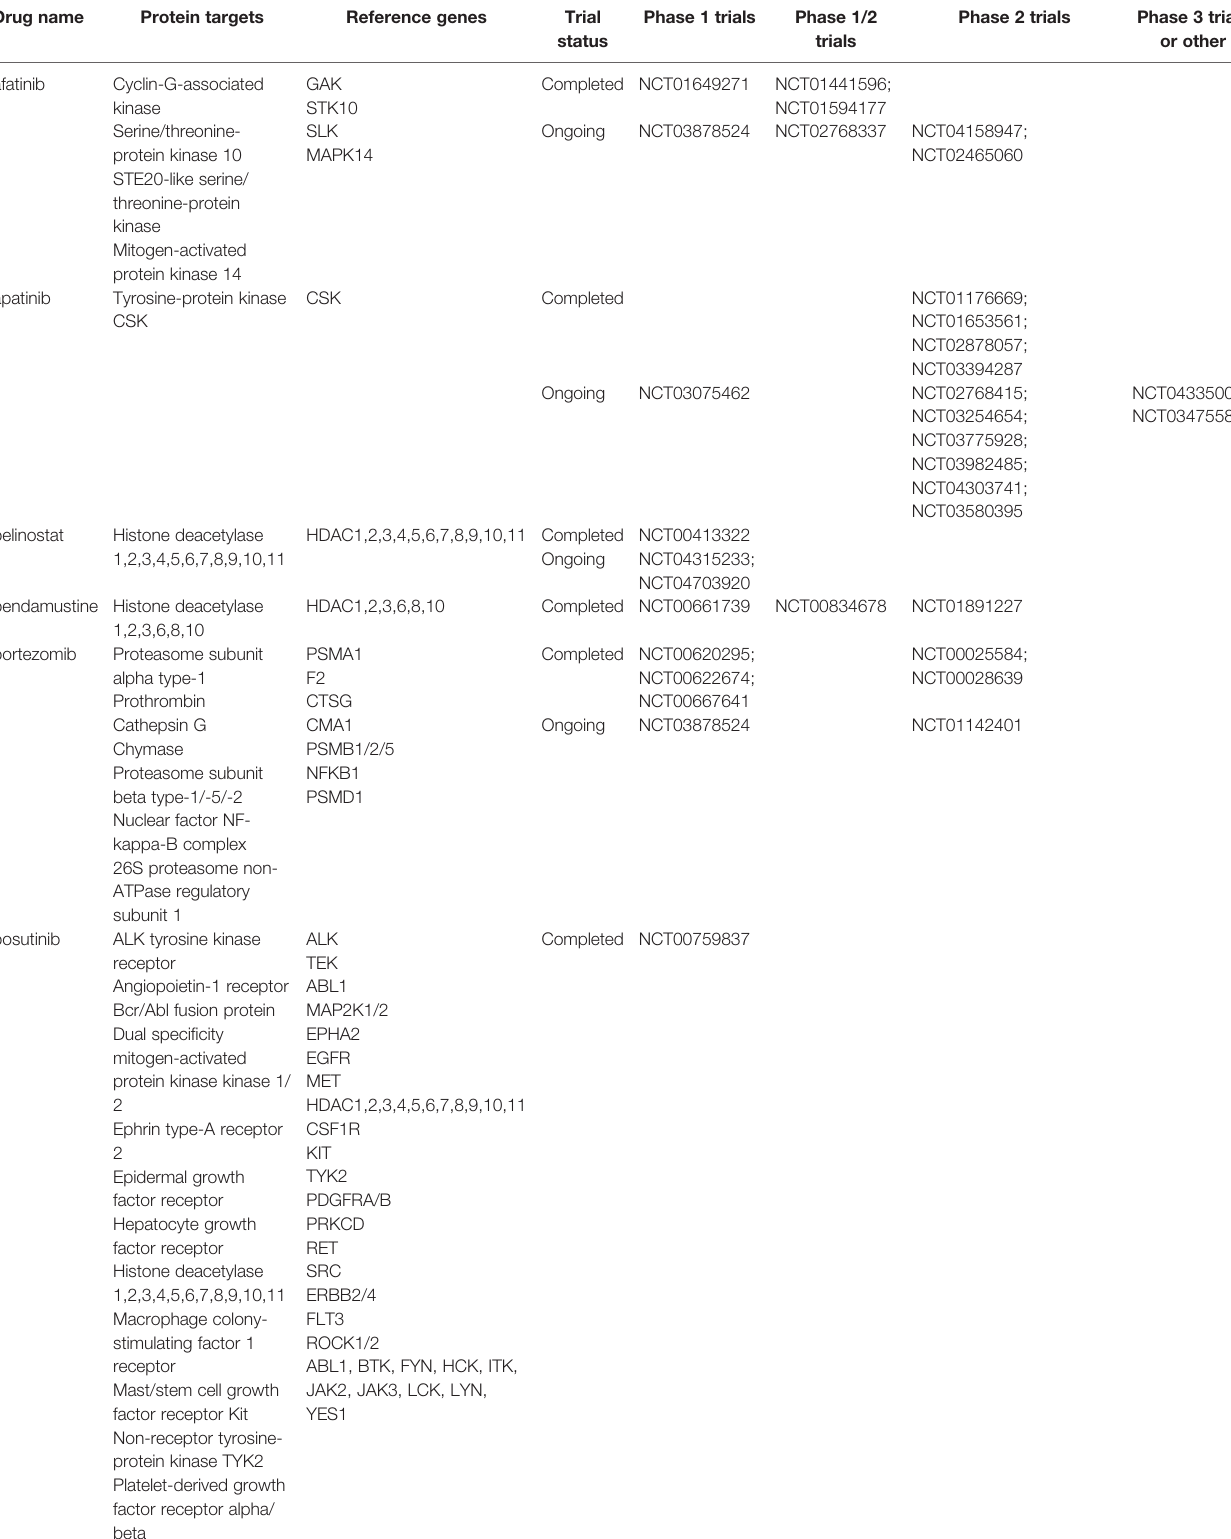
TABLE 3 | Anticancer drugs identi fi ed through the clonal proteome that are under clinical investigation in breast cancer patients for repositioning. Drug